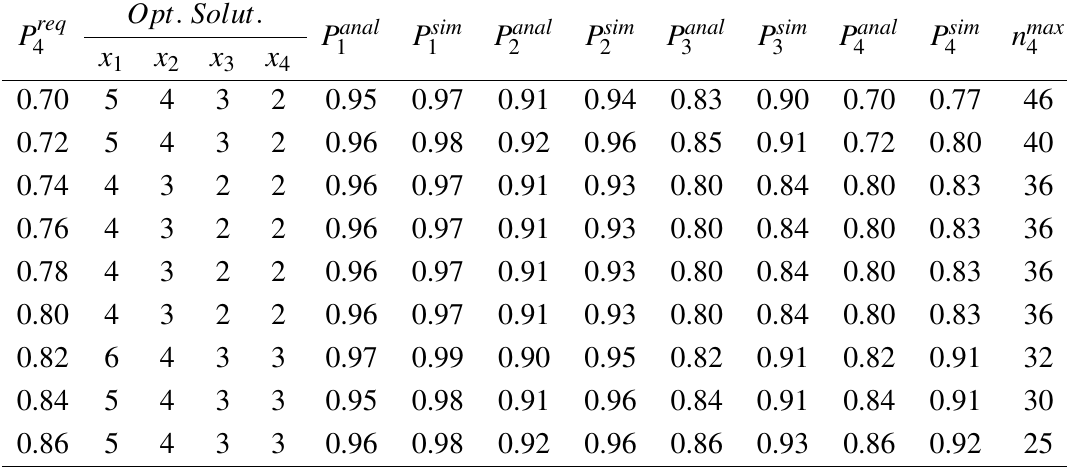
Table 4. The effects of the PDR requirement for class Q greedy algorithm and the maximum number of nodes in class Q n = 20, P req 3